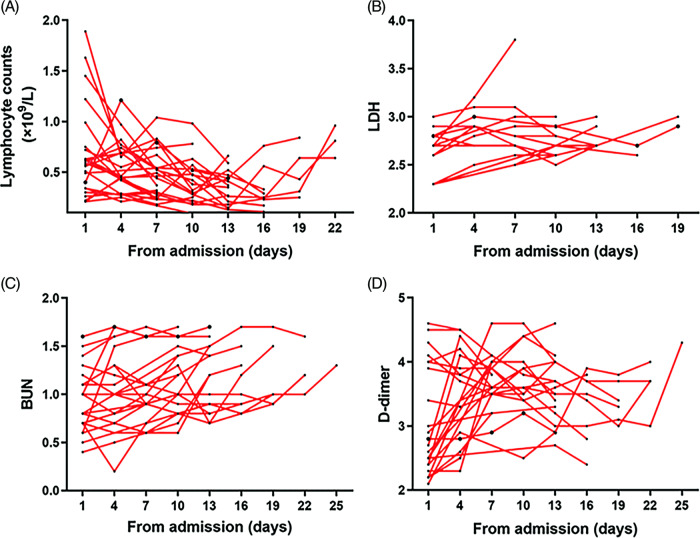
Temporal changes in laboratory markers from illness onset to death in nonsurvivors. (A) Line chart shows a dynamic decrease in lymphocyte counts after hospitalization. (B) LDH, (C) BUN, (D) D-dimer values basically show an upward trend throughout the clinical course. Lymphocyte counts, BUN, and D-dimer were obtained from 24 nonsurvivors. LDH was obtained from 15 nonsurvivors. LDH, BUN, and D-dimer values were log10-transformed for analysis, due to the wide range of variation. LDH, lactate dehydrogenase; BUN, blood urea nitrogen.